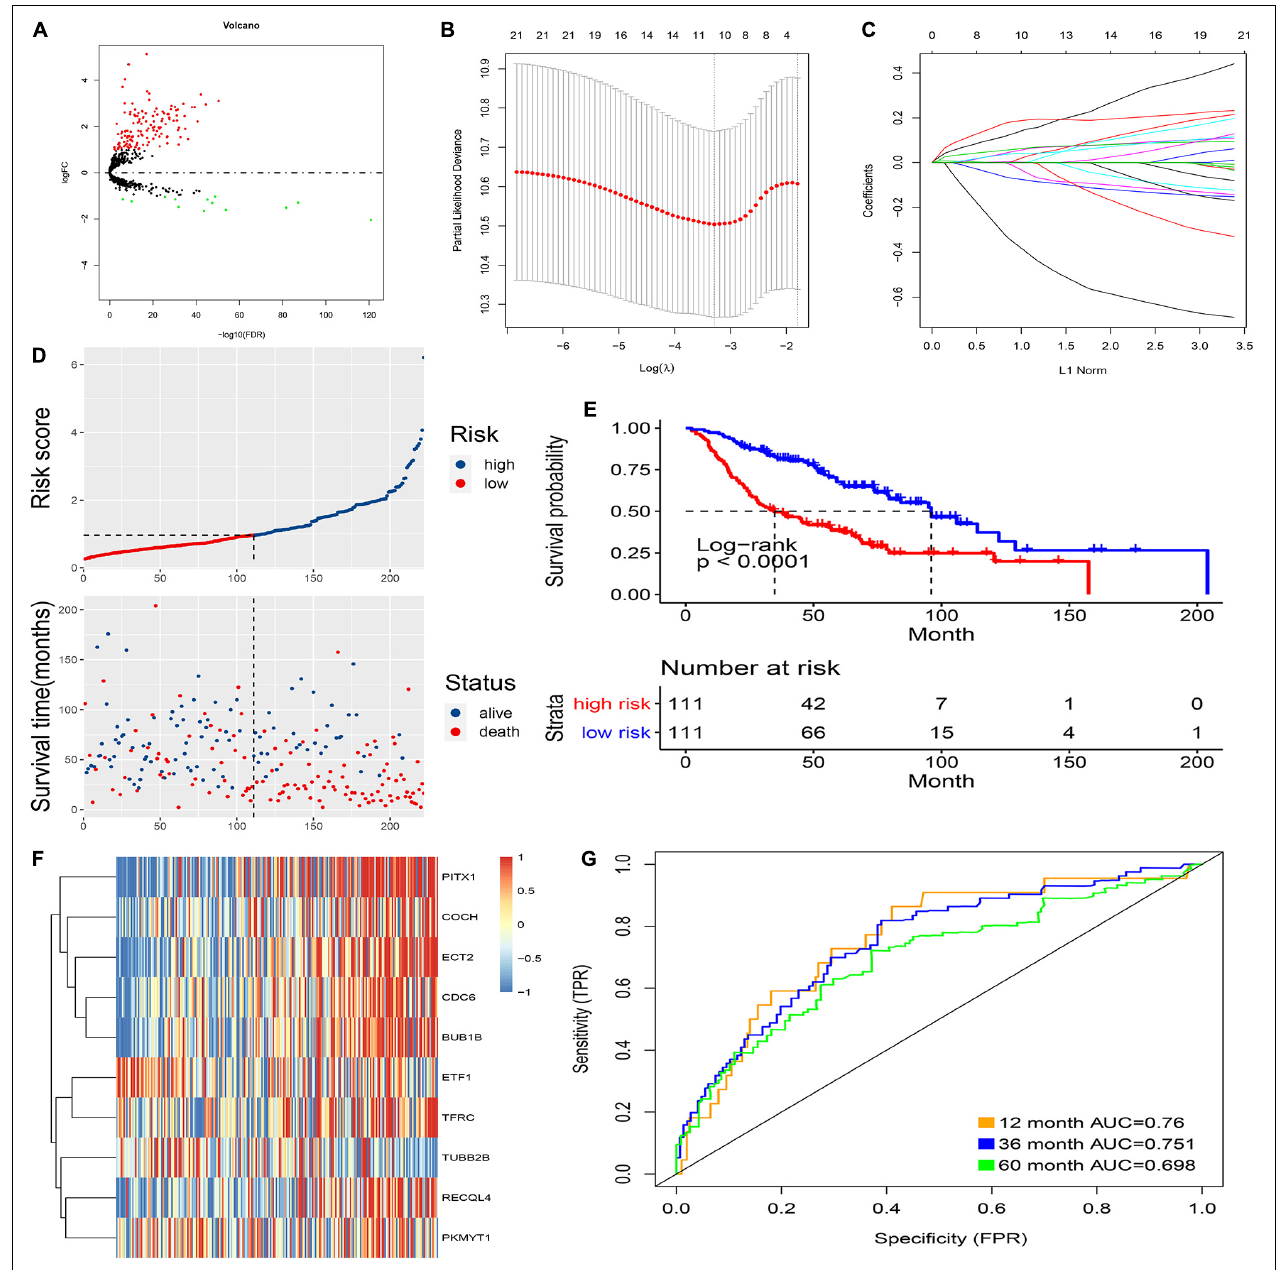
FIGURE 2 | Prognostic model of the training cohort and risk signature with the 10 CCRGs. (A) LUAC-specific CCRGs were screened out. (B) The association between deviance and log( λ ). (C) The association between coefficients of genes and log( λ ). (D) Risk score of the high and low groups. (E) Survival analysis of the high and low groups. (F) Heatmap of the expression of 10 CCRGs. (G) The AUC of the